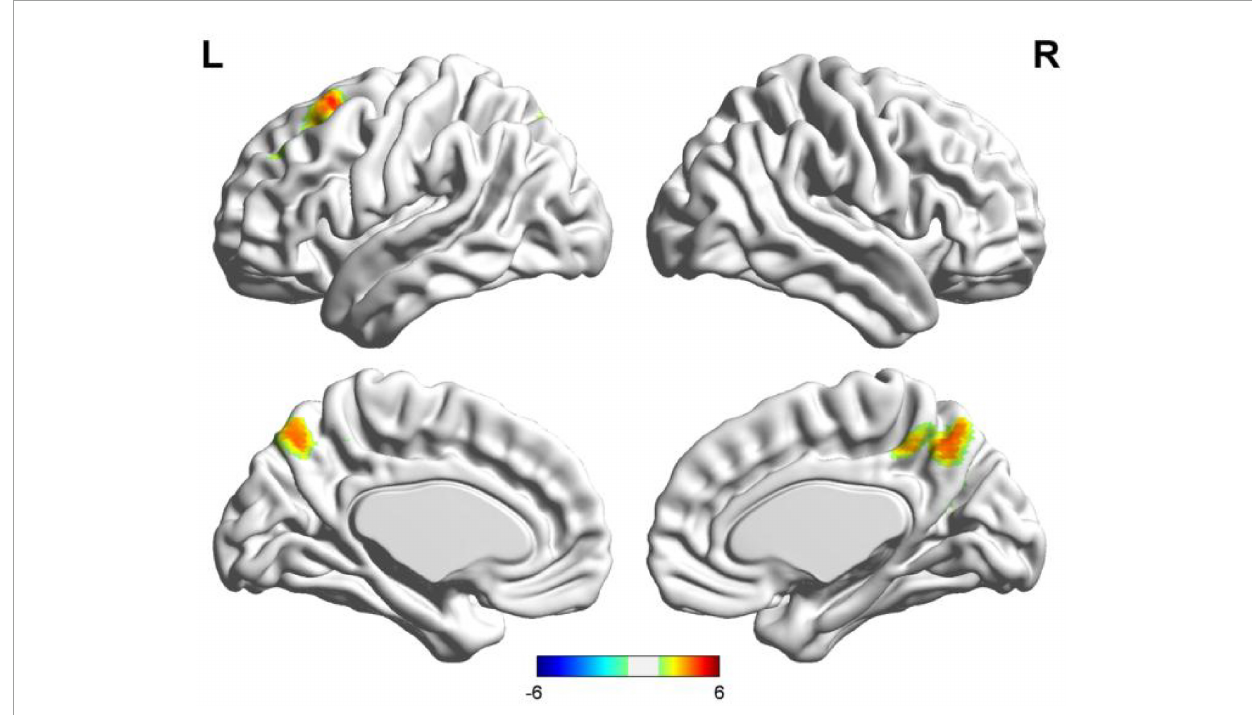
FIGURE6 Results of two-sample t -test of language lateralization in terms of Wernicke’s area (the seafarer group > the non-seafarer group; p 0.005, cluster size > 200 voxels, corresponding to corrected p FWE 0.05). R: right hemisphere, L: left